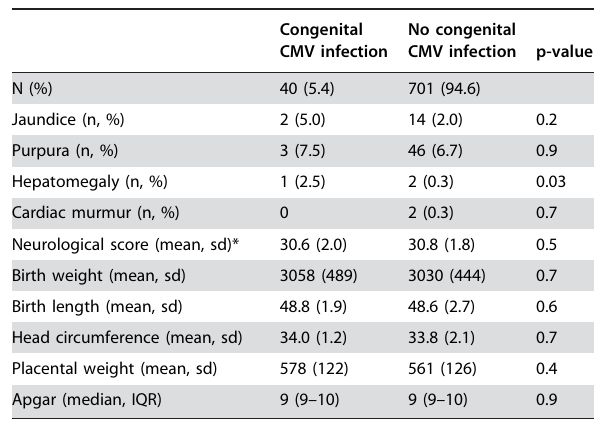
Table 3. Clinical characteristics at birth of children with